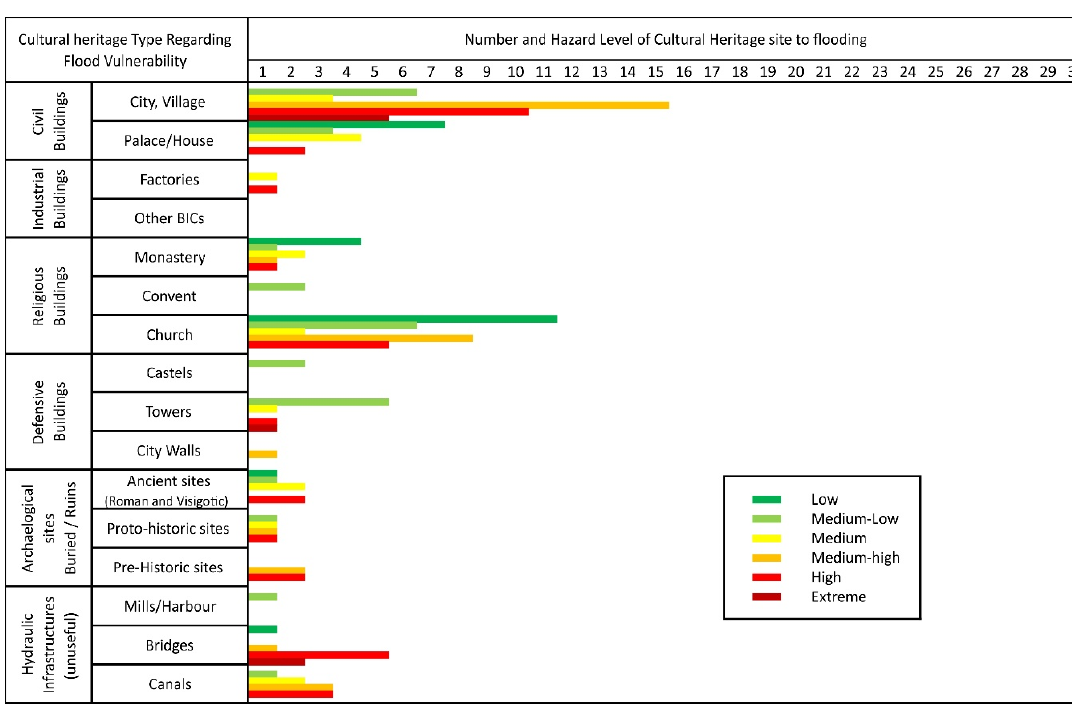
Figure 6. Spatial distribution of BICs in Castile and León region and their associated flood vulnerability level.